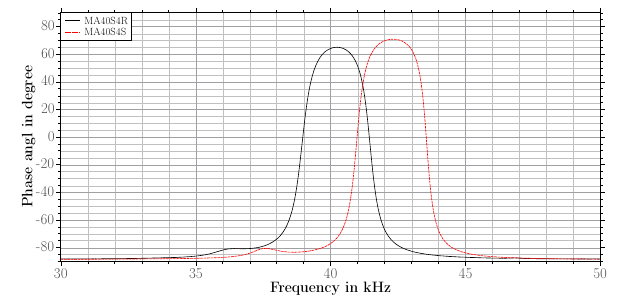
Figure 4. Impedance phase angle of the piezoelectric receiver and sender. The zero-crossings indicate the resonance frequencies.